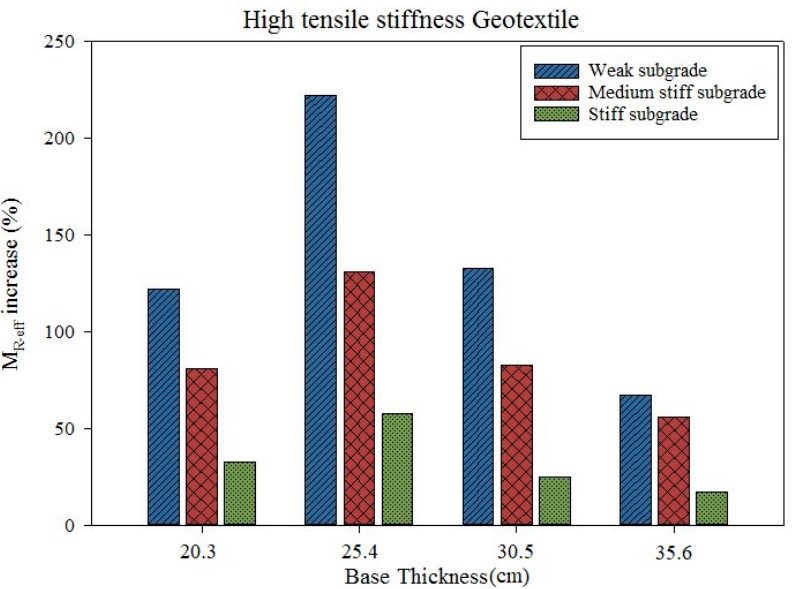
Figure 12. Changes in M R-eff increase of pavement reinforced with a high tensile stiffness geotextile for different subgrade stiffnesses.